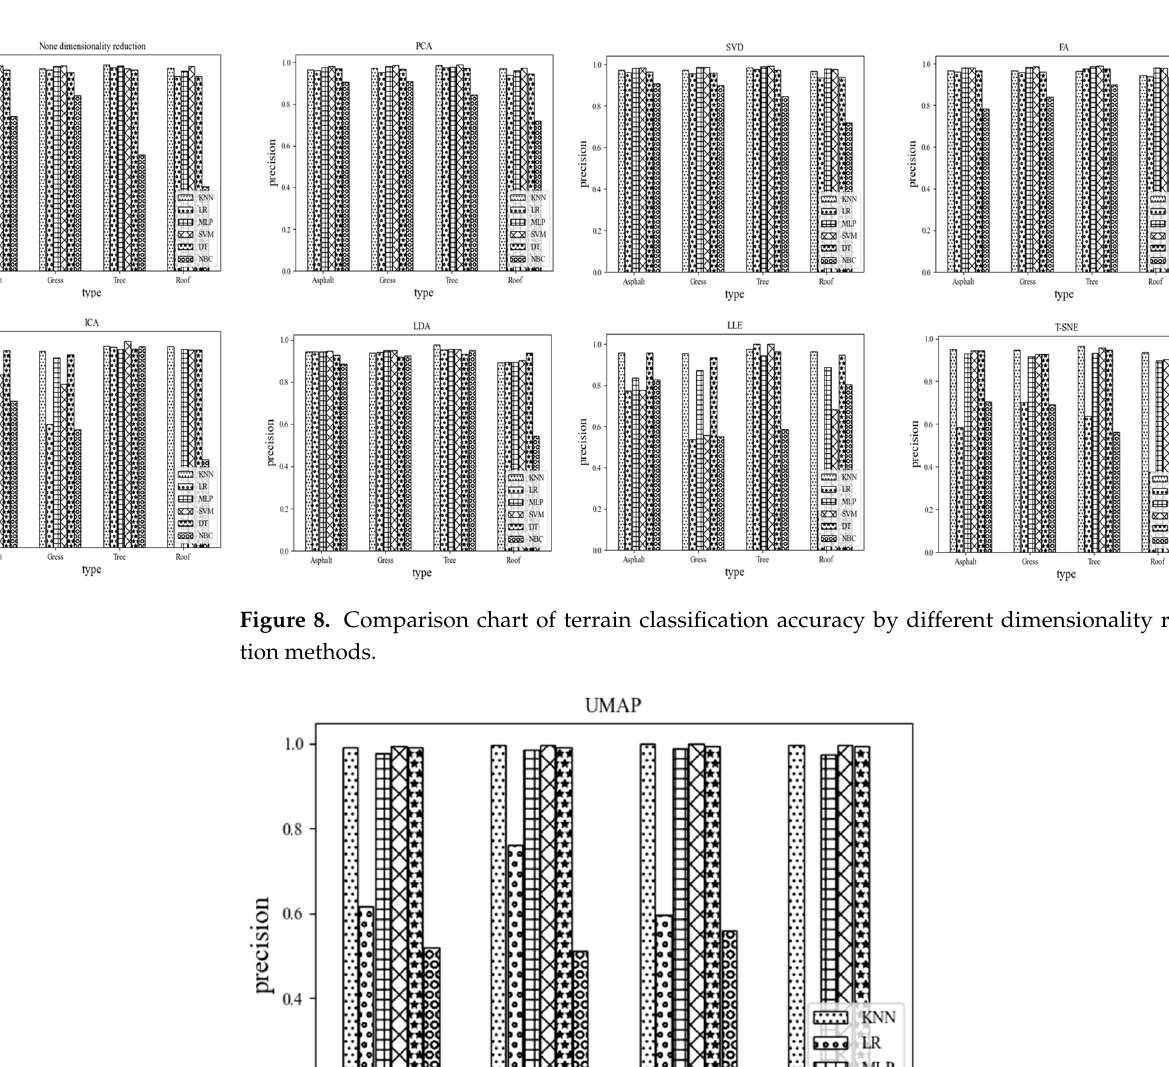
Figure 8. Comparison chart of terrain classification accuracy by different dimensionality reduction methods.